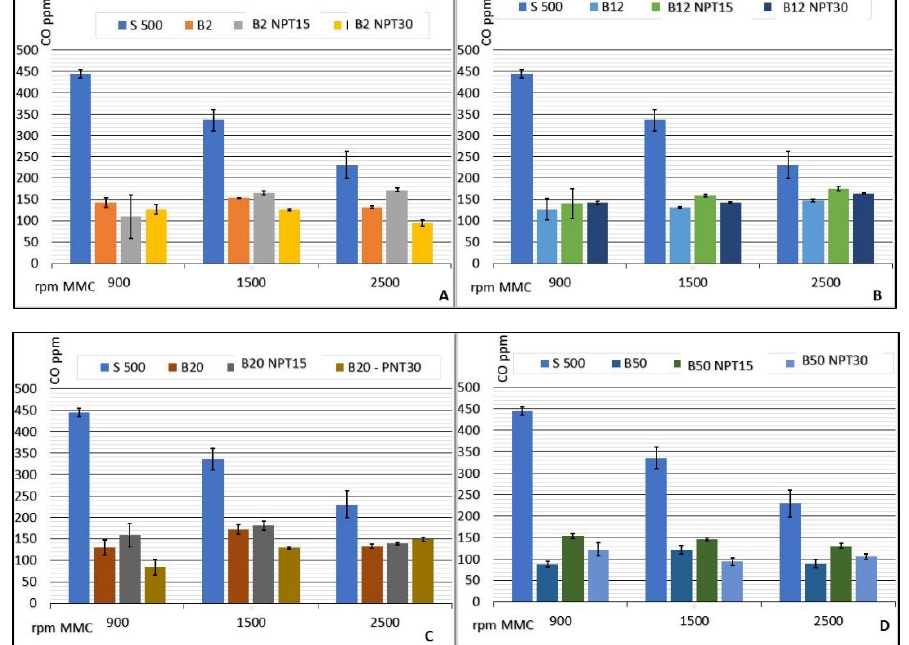
Figure 5. Results for CO emissions (ppm) from the CCE for biodiesel added to common diesel in the proportions of 2% ( A ), 12% ( B ), 20% ( C ), and 50% ( D ) for biodiesel obtained by CC, and for B100-NTP15, B100-NTP30, and S-500 at different engine speeds (rpm).